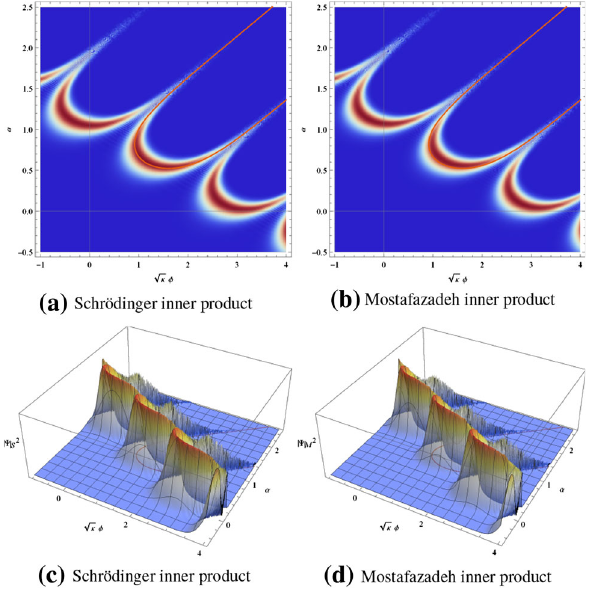
Fig. 4 Poissonianwavepacketsestablishedbythewavefunctionswith discrete spectrum and the corresponding classical trajectories for the phantom model. Parameters are V = 1, λ = 2, ¯ ω 2 = 10240 / 9, mean- while a = 1 is fixed